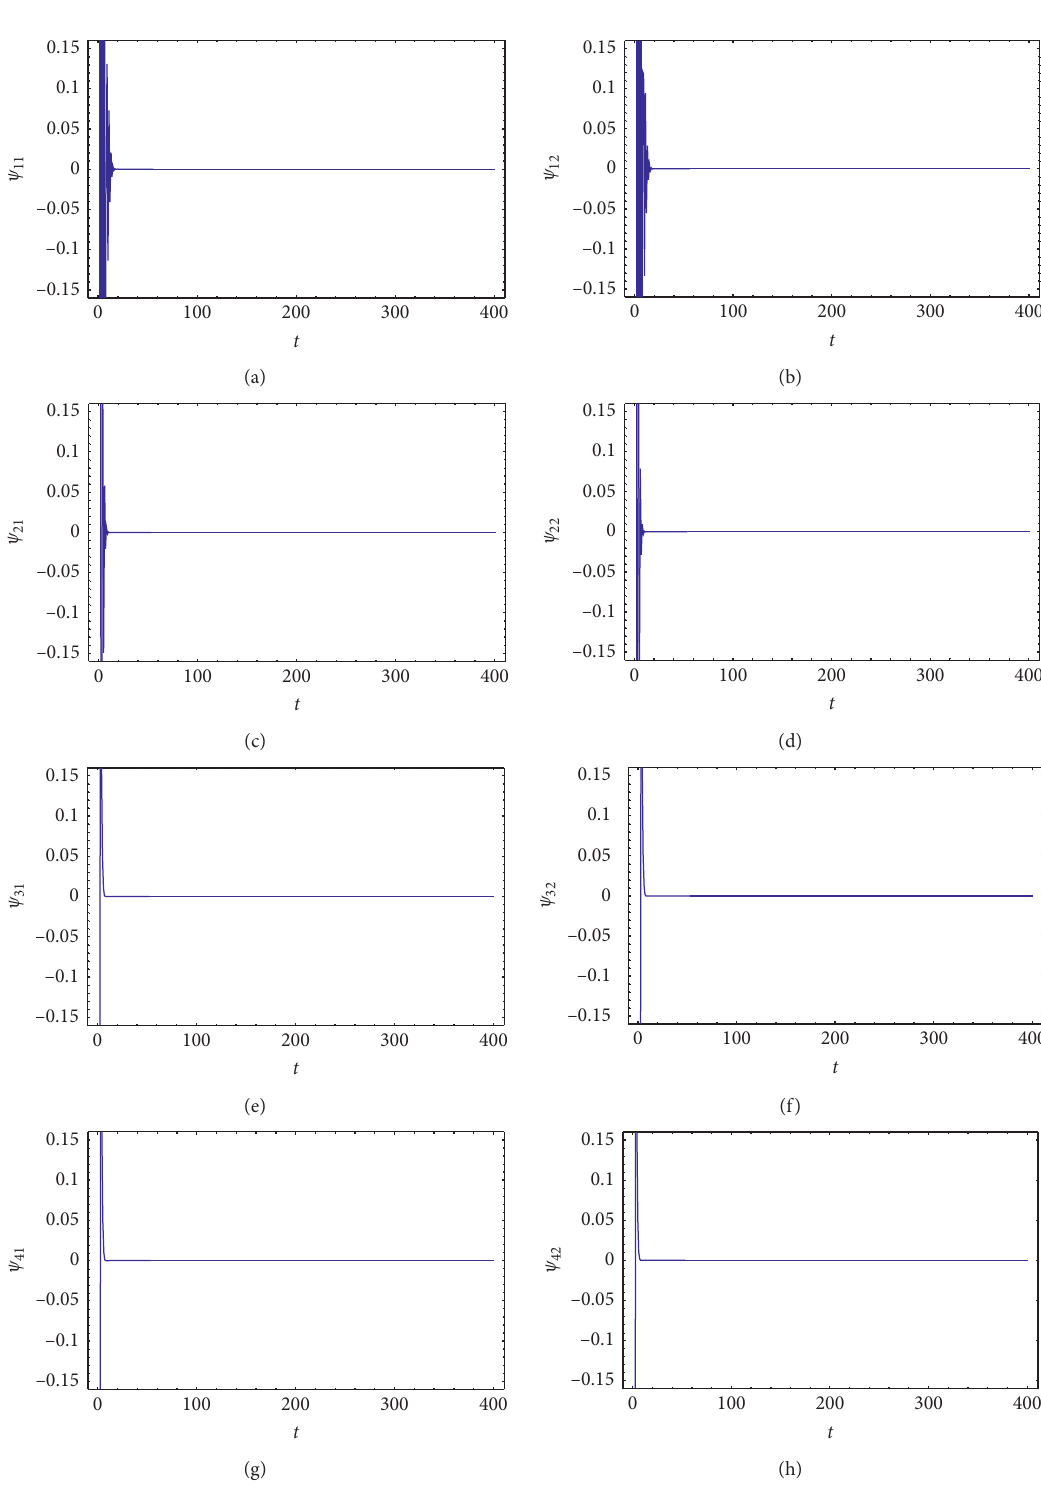
, t ) layout. (b) ( Ψ 11 , t ) 42